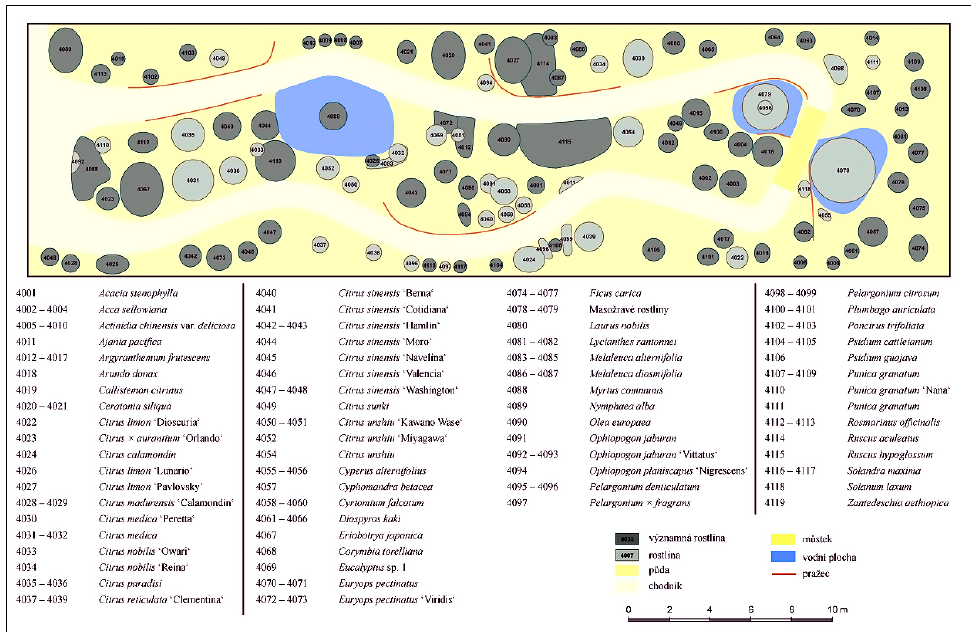
Fig. 10. Plan of the subtropical greenhouse (Dančák et al. 2013c) year round. Along the trails, there are signs indicat- route, which is shown by a red line. The colour red